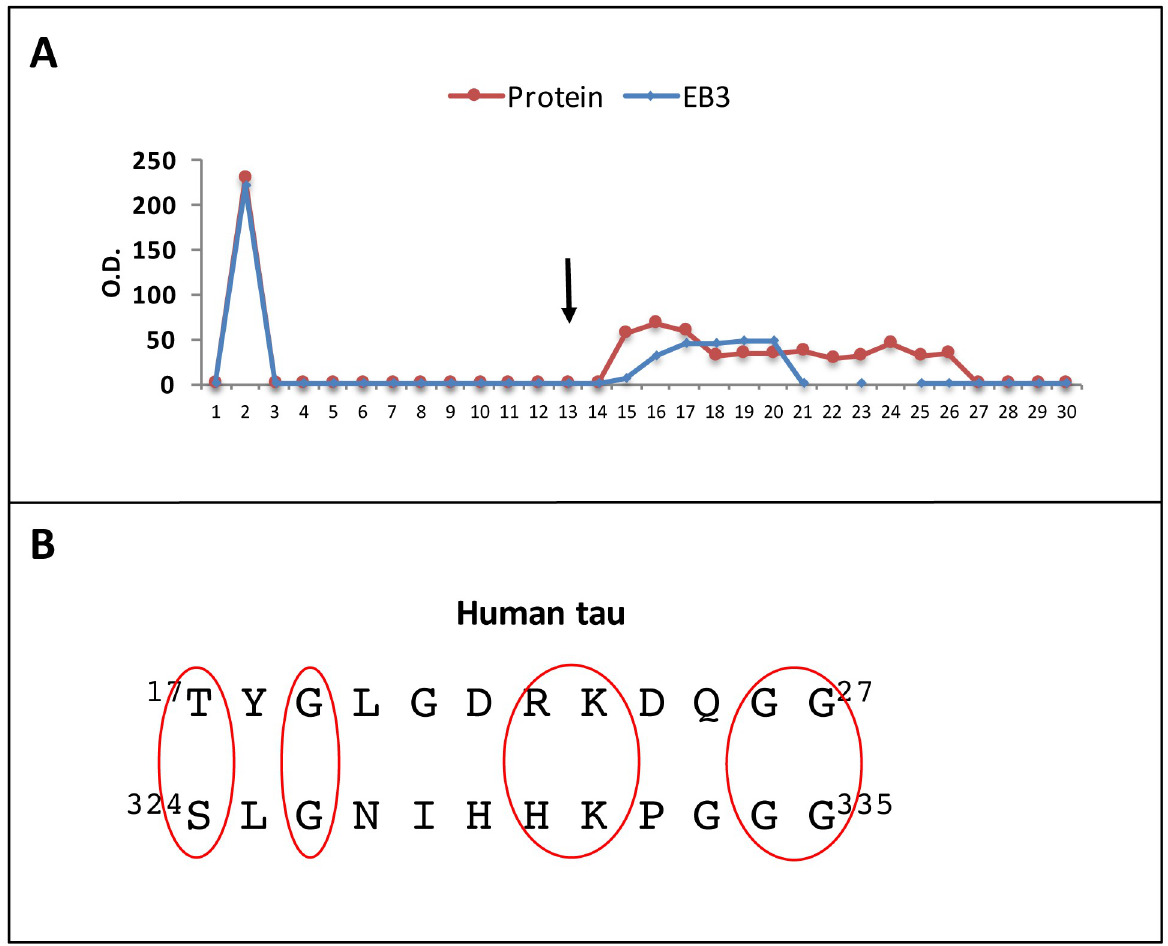
Fig 3. Binding of EB3 protein to a tau peptide containing microtubule binding repeats 1, 3 and 4. A) Tau 3R fragment containing tau repeats 1, 3, and 4 was covalently linked to a Sepaharose column and a human brain cell extract was chromatographed on that column, in a similar fashion to that indicated in Fig 3. The dot blot analysis indicated the presence of EB3 in the bound protein fractions. B) The similarity of human tau sequences spanning residues 17–27 and 324–335 (within the microtubule binding domain) is shown.